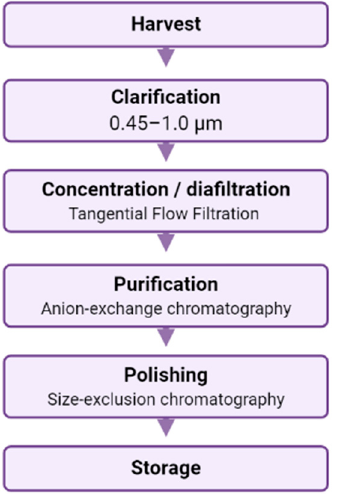
Figure 4. Flow chart of an example of downstream processing lentiviral vectors from harvested material.